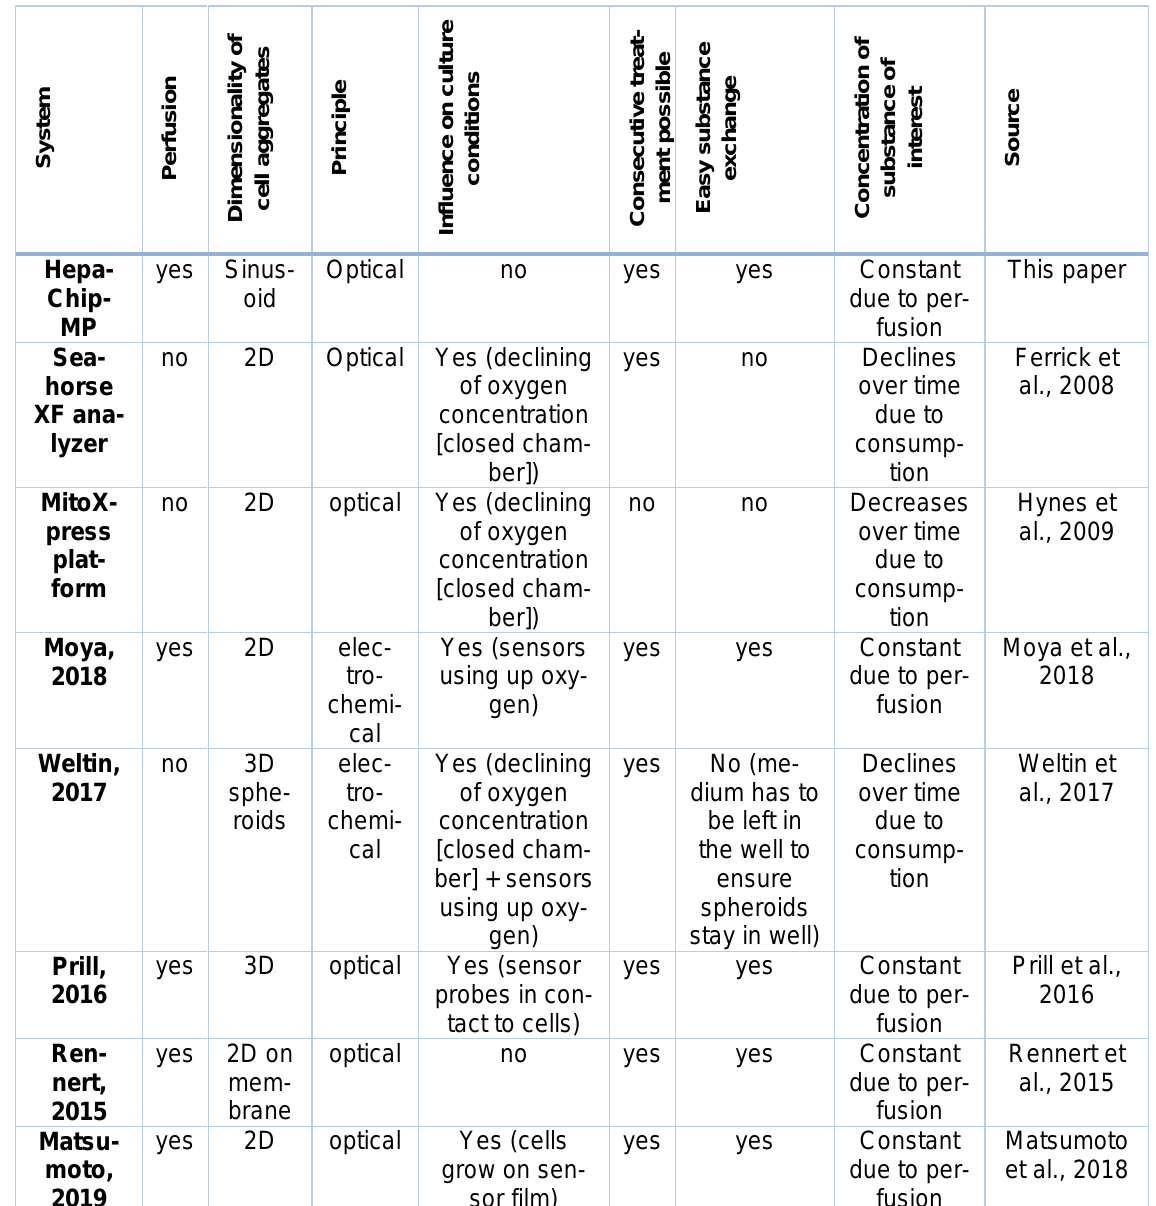
Table 2: Comparison of features of the HepaChip-MP to other available systems to measure oxygen consumption in cell culture systems